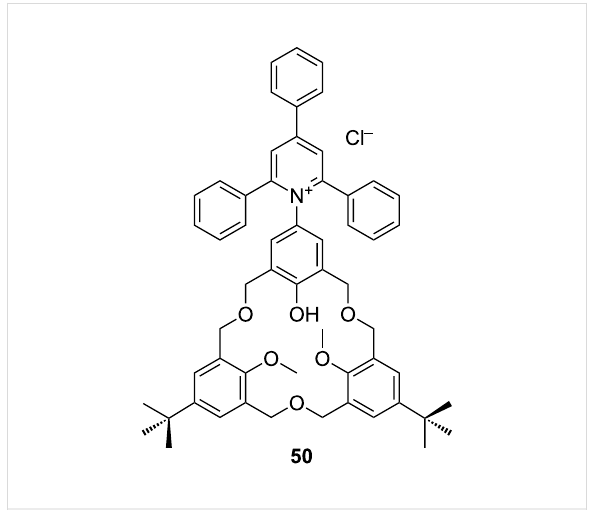
benzylamine (BzNH 2 ) or triethylamine (Et 3 N), but cyclohexyl- amine ( c -HexNH 2 ) and n -butylamine ( n -BuNH 2 ) bind with a concomitant colour change to blue.